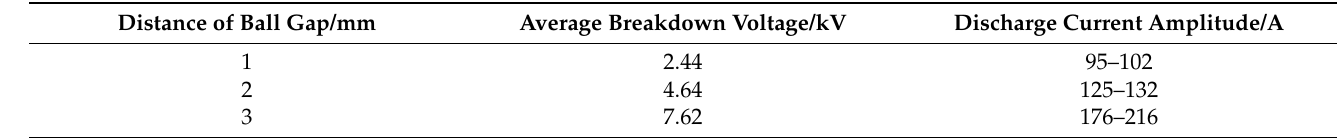
Table 1. Relationship between gap spacing and breakdown